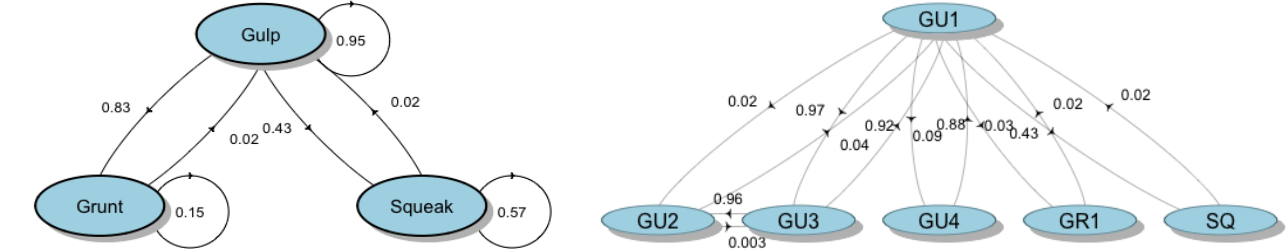
Figure 7. Transition diagrams of bray-call series obtained from first-order Markov chain model. The circles represent different vocal elements, and the values represent the transition probabilities.